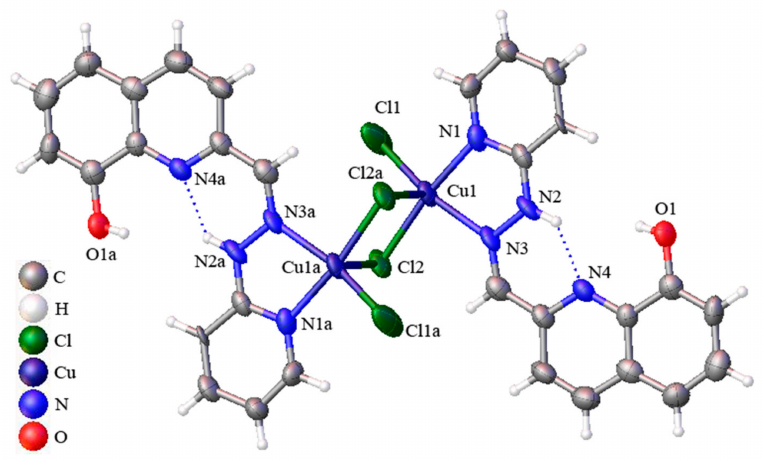
Figure 1. The crystal structure of Cu(II) complex 1 .